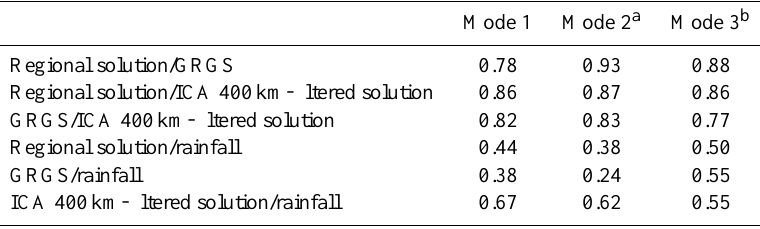
Table 1. Correlation values between PCA spatial components (mode 1, 2 and 3) of different GRACE-based data sets and rainfall BoM product.